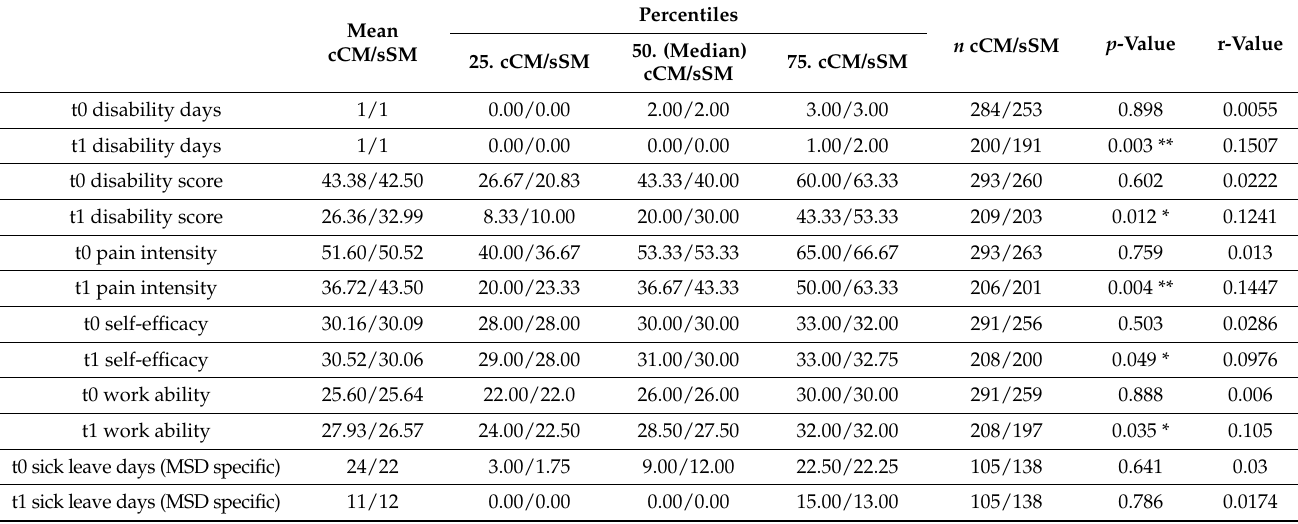
Table 3. Group differences’ analyses in Module A: coordinating case management (cCM) vs. supported self-management (sSM) at baseline (t0) and follow-up (t1) (* = p < 0.05, ** = p <